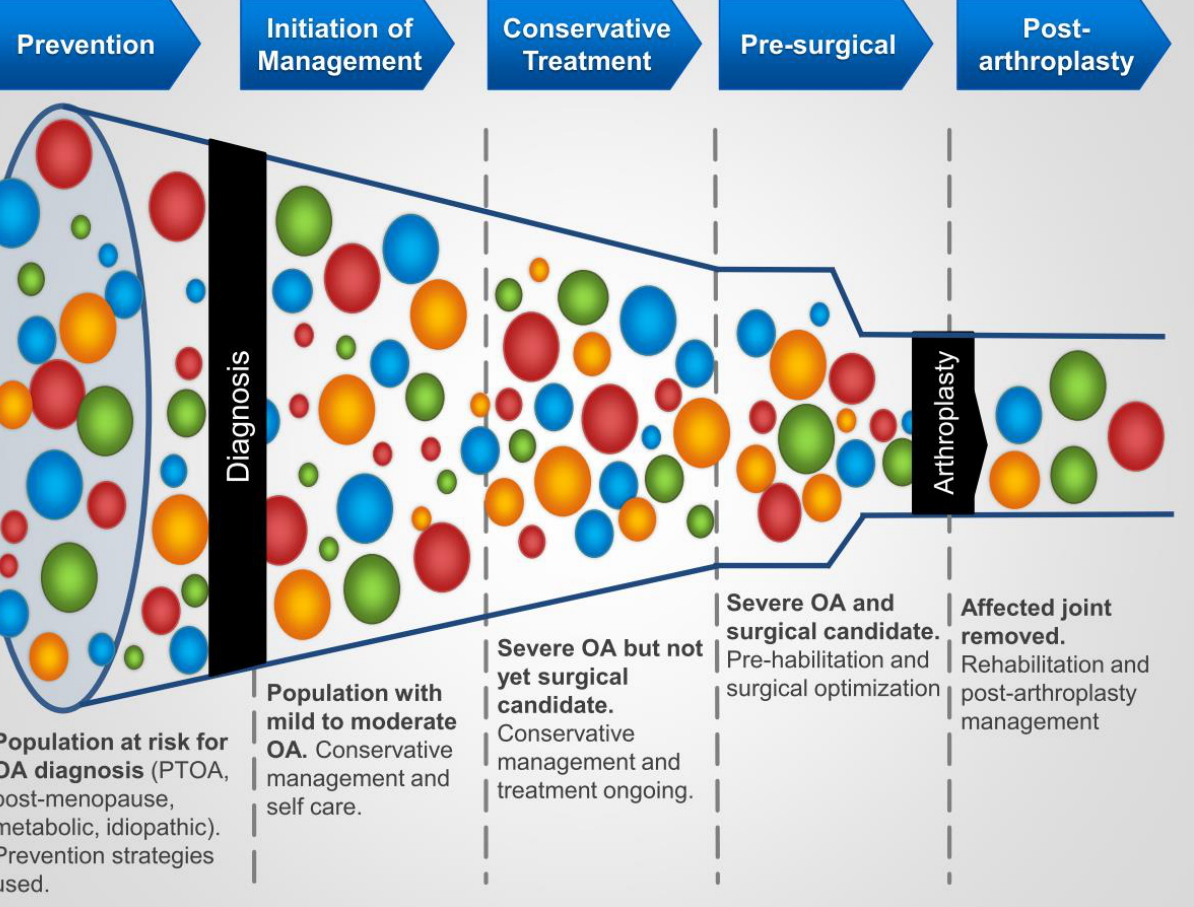
Figure 1. The OA patient “funnel” depicting the ever-increasing bottleneck for joint arthroplasty as the number of patients needing effective conservative care expands. From Hart et al. [11].